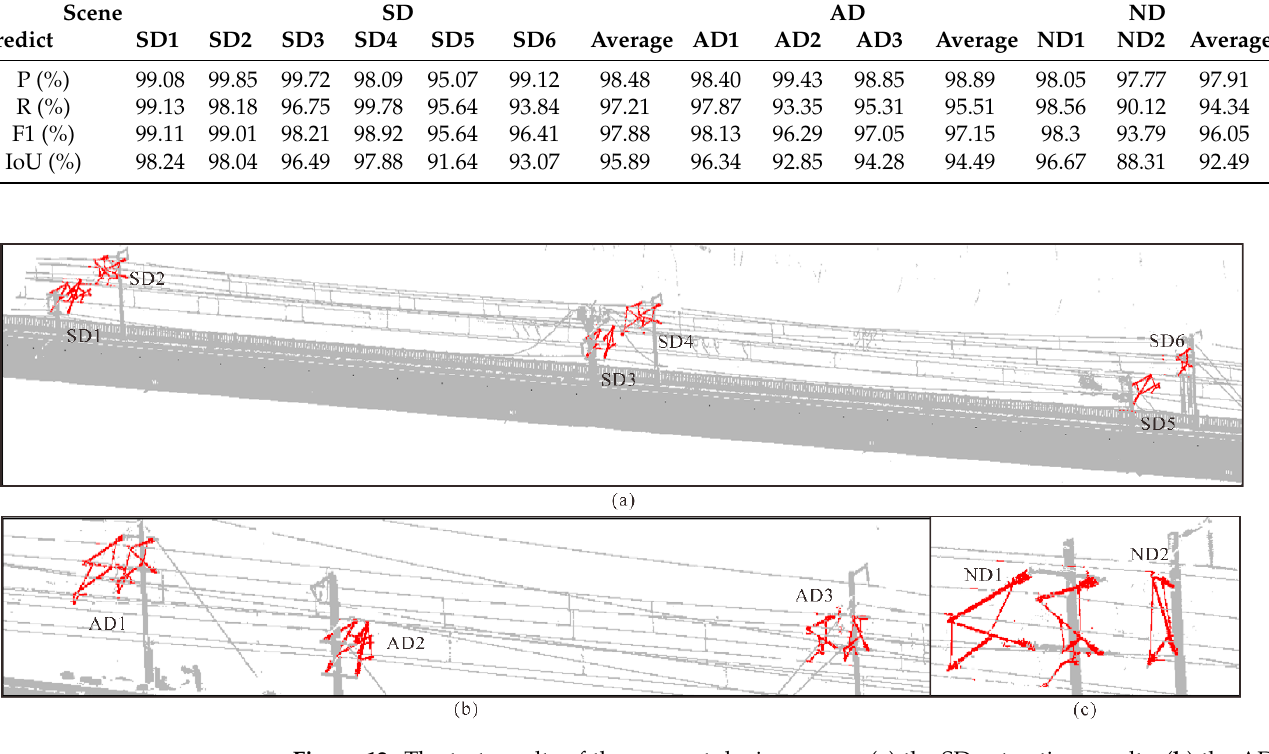
Figure 13. Differences in the extraction effects of the integrated PF, RC, and VPF filters and inte- grated RC and VPF filters. Specifically, the blue results are the extractions of the integrated PF, RC, and VPF, and the red results are the extractions of the integrated RC and VPF. ( a ) The application of the two filters on the SRSD. ( b ) The application of the two filters on the DRSD. ( c ) The application of the two filters on the SFSD. ( d ) The application of the two filters on the LSD.